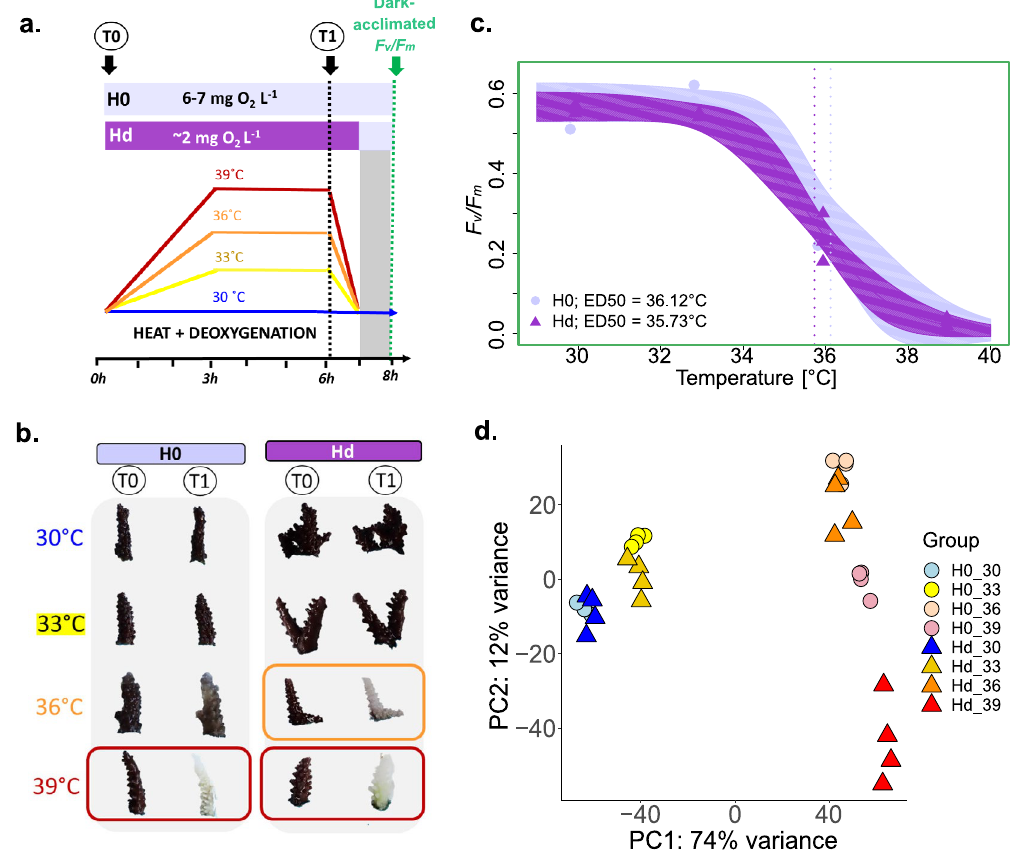
Figure 1. Deoxygenation lowers the thermal threshold of coral bleaching. ( a) Short-term thermal stress assay profiles with respective 3 h heat-hold temperatures at 30 °C (control/baseline), 33 °C, 36 °C, and 39 °C under normoxic (H0) and deoxygenation (Hd) conditions. For Hd, the deoxygenation condition was applied for a total of 6 h (during daylight hours). Samples for RNA-Seq analysis were taken after 6 h, i.e. at the end of the heat- hold as indicated by T1. Measurements of maximum photosynthetic efficiency of PSII ( F v /F m ) of the additional fragments were taken following 1 h dark-acclimation. (b) Representative photographs of coral fragments from time point T0 and T1 under H0 and Hd. (c) Maximum photosynthetic efficiency of PSII ( F v /F m ) in relation to temperature for H0 vs. Hd (n = 3 for each) and determined ED50 thermal tolerance thresholds as a proxy for coral bleaching susceptibility (sensu 29,49 ). Solid lines reflect the log-logistic model with 95% confidence intervals represented by the shaded areas. (d) Principal Component Analysis (PCA) of 20,115 transcripts comparing all H0 and Hd samples across all heat stress temperatures (n = 4 for each). The x- and y-axes indicate the percent of the variance explained by the first and second principal component,